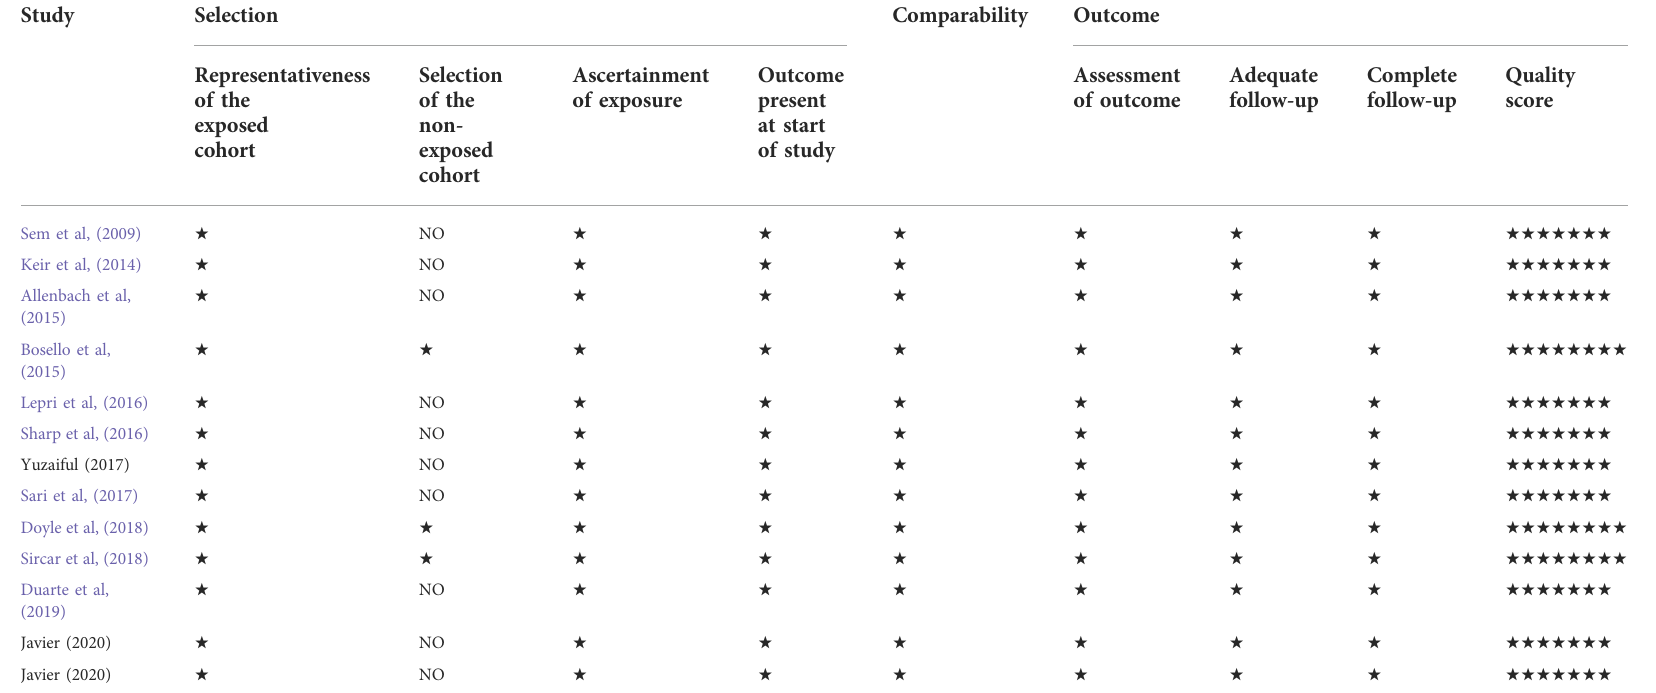
TABLE 2 Quality assessment of included studies by Newcastle – Ottawa scale